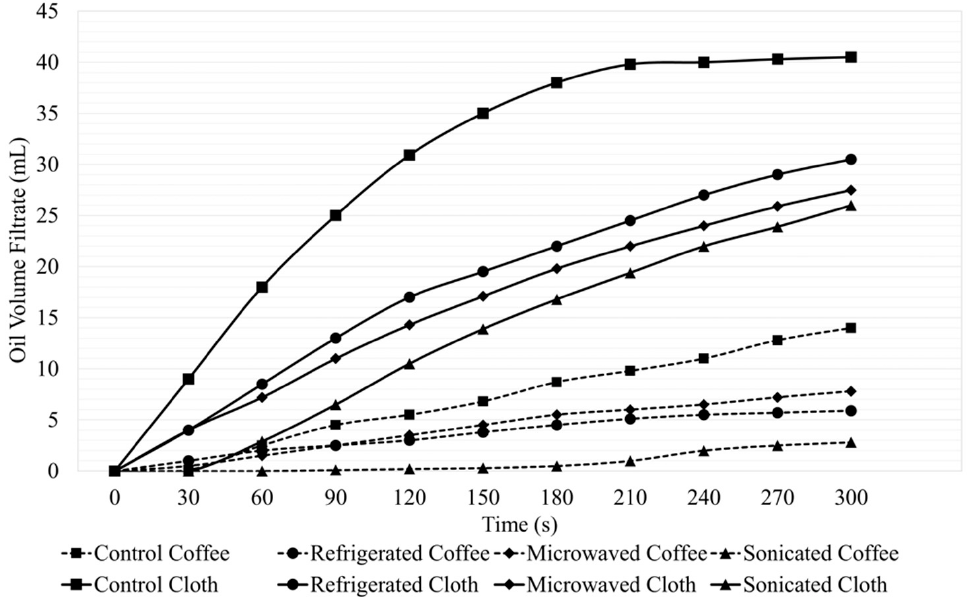
Figure 3. Volume of oil filtrate as a function of time.